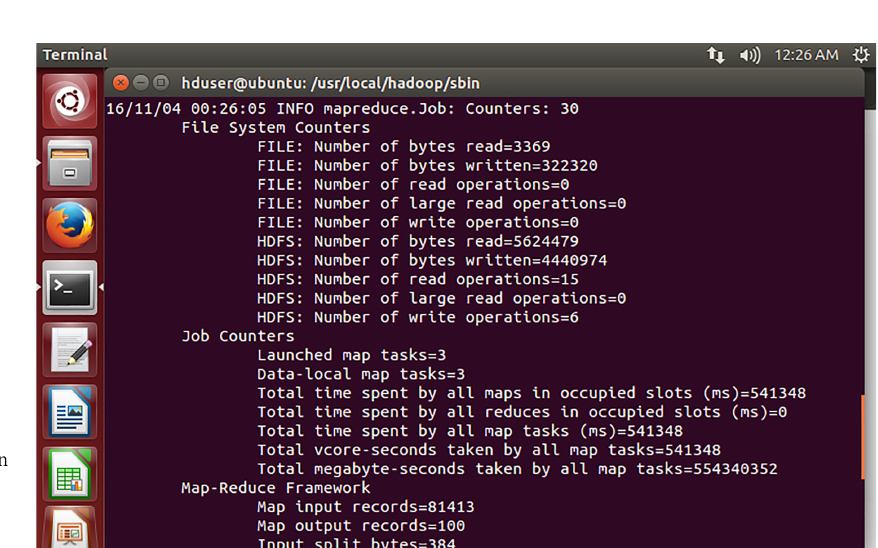
Table 2. Descriptivestatisticsof quantitative variables in the dataset